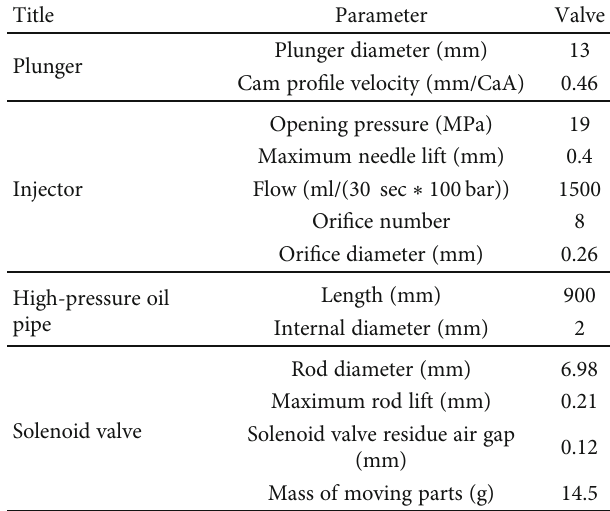
Table 1: Main parameters of FIS of the ECU